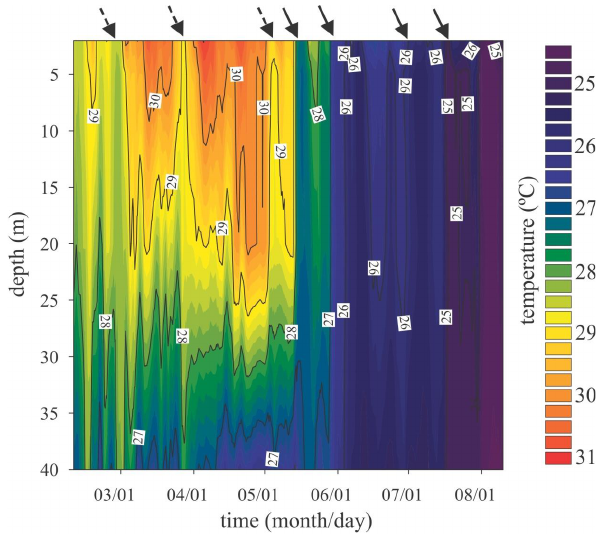
Figure 3: Temperature contours (ºC) from the thermistor-chain data measured near the dam (MAN-13). Arrows indicates mixing process.